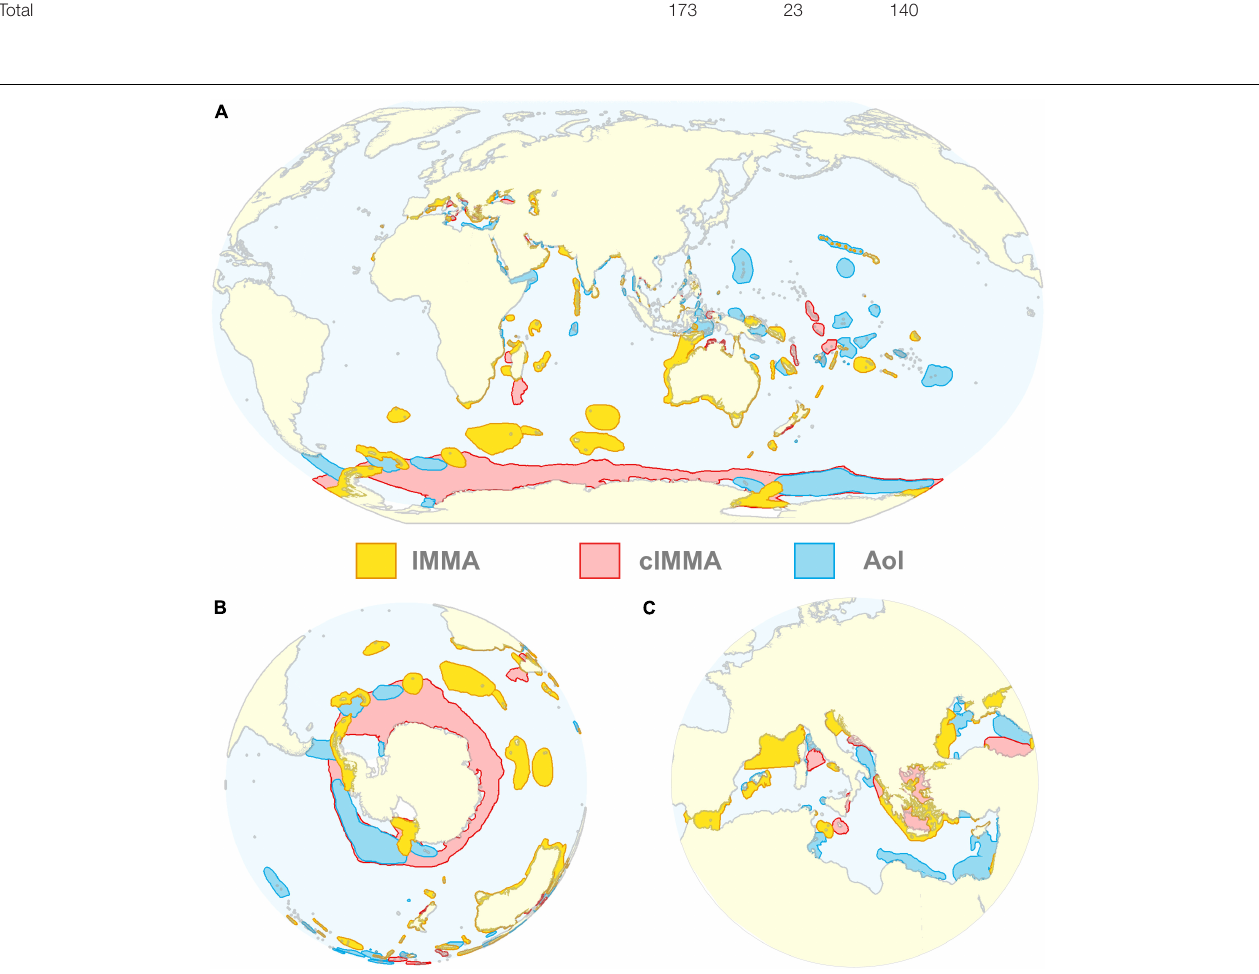
FIGURE 1 | The IMMA Network as of December 2021 displayed in both a Global (A) , Orthographic South Polar (B) , and Mediterranean (C) projection. Important Marine Mammal Areas (IMMAs) are displayed in gold, while candidate IMMAs (cIMMA) are red and Areas of Interest (AoI) are shown in blue.